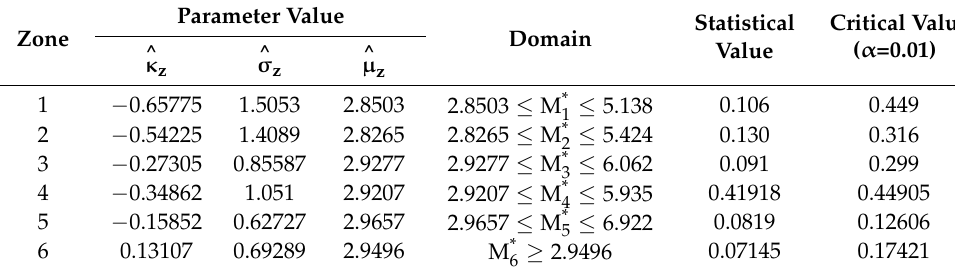
Critical Value Statistical Domain Value